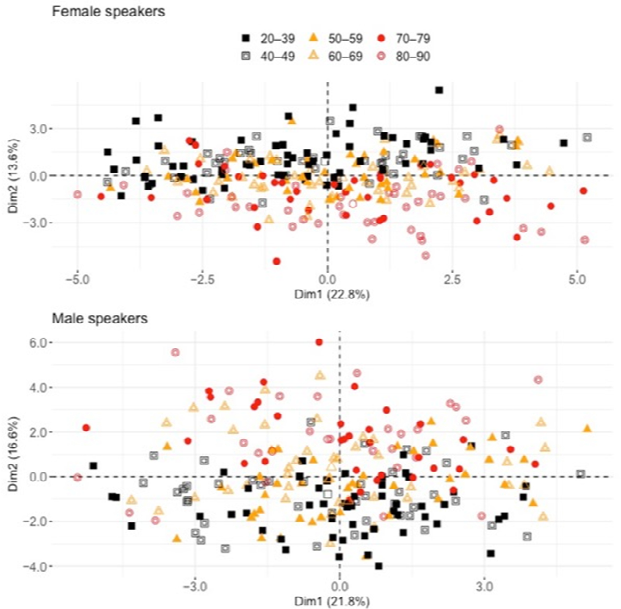
Figure 3. Distribution of individuals over the space defined by the first two components (PC1 = Dim1 in x -axis and PC2 = Dim2 in y -axis) for the male ( top ) and female ( bottom ) speakers. In order to see whether speakers are clustered by age along these dimensions, each speaker has been coded (colored shapes) according to its age: below 40 y.o.a., then by decades. Younger (filled and unfilled black squares) and older participants (filled and unfilled red circles) are divided along Dim2. The fact that Dim2 appears in a reverse order for the male and female speakers is not meaningful here.